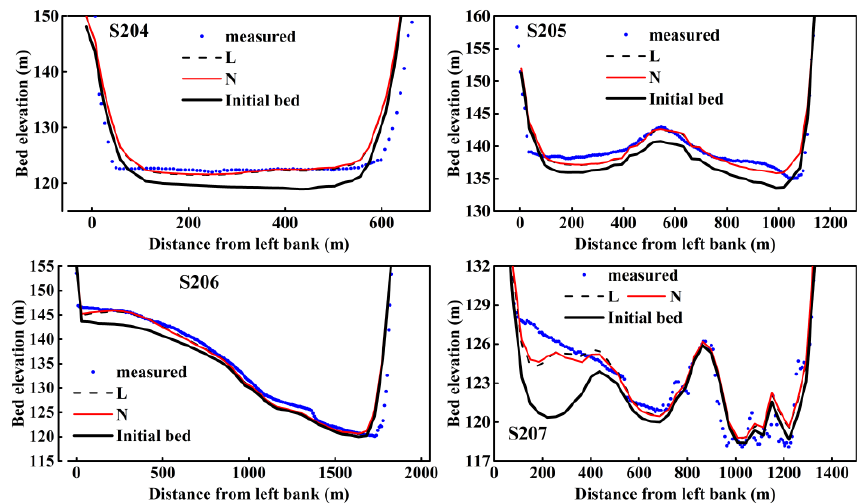
Figure 7. Comparison of bed elevation at cross-sections between measurements and predictions.